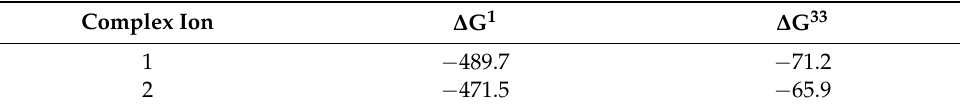
Table 2. Calculated Gibbs energies for complex-formation in the gas-phase, ∆ G 1 , and in a methanol environment, ∆ G 33 , for the complex-formation reaction with methanol solvated Ga cation